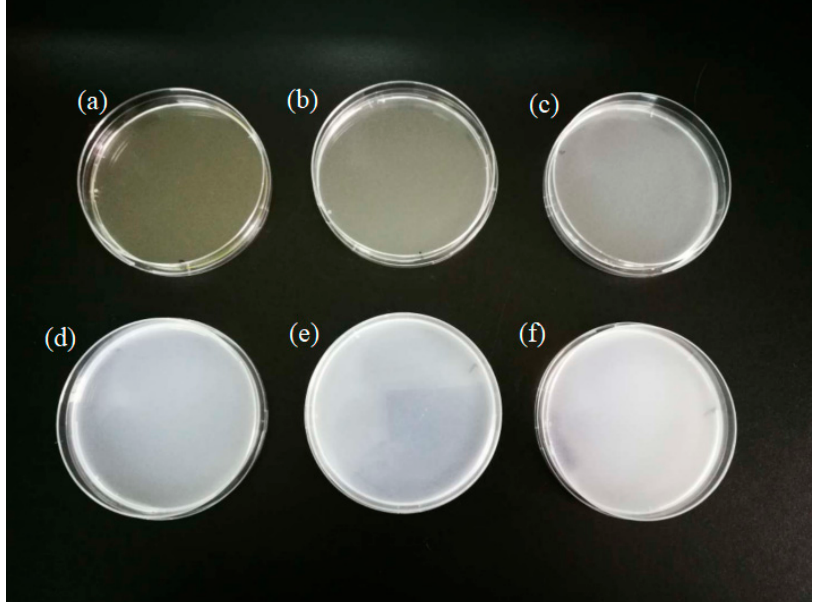
Figure 1. Images of chitosan-based coating film with TiO 2 nanoparticles ( a ) 0; ( b ) 0.01%; ( c ) 0.03%; ( d ) 0.05%; ( e ) 0.07%; ( f ) 0.09%.